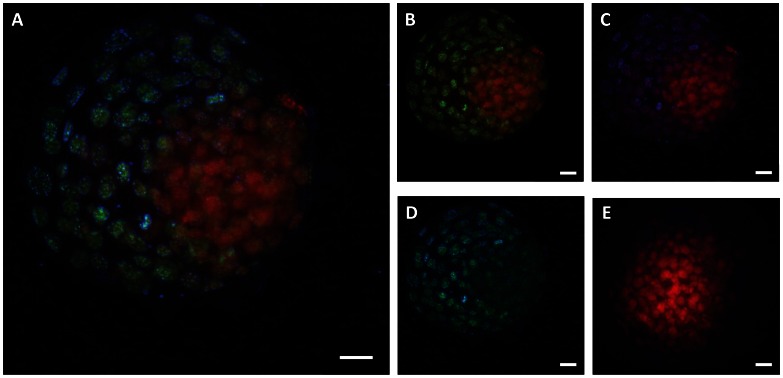
Representative images of an embryo in which labeling with CDX2 (blue) was used to evaluate immunoreactive 5-methylcytosine (green) in ICM (CDX2-negative) and TE (CDX2-positive).Nuclei of all cells were labeled with propidium iodide (red). Panels represent merged images for all three fluorescent labels (A), 5-methylcytosine and PI (B), CDX2 and PI (C), CDX2 and 5-methylcytosine (D) and control antibodies for anti-5methylcytosine and anti-CDX2 as well as PI (E). The scale bar is 20 µm.